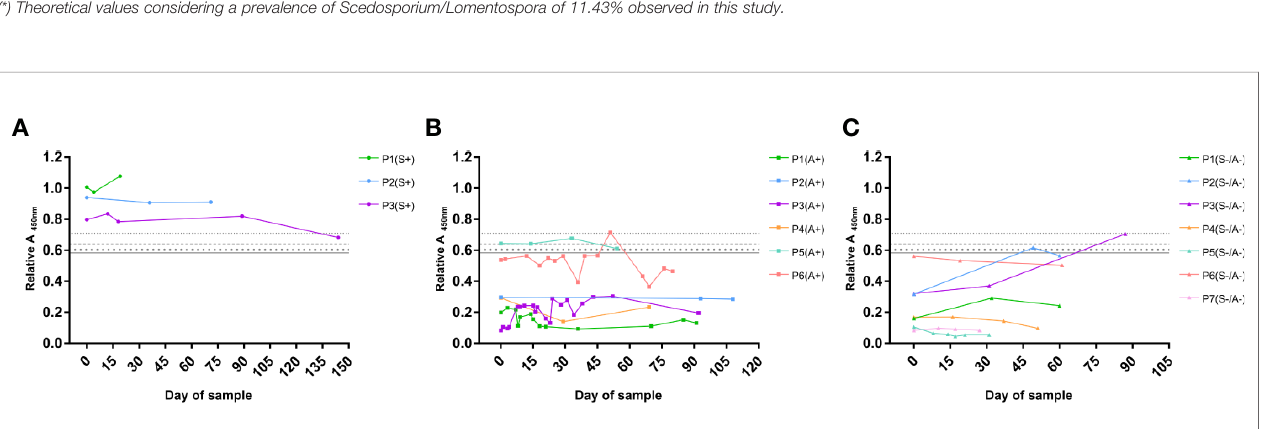
FIGURE 8 | Monitoring of speci fi c IgG serological response of CF patients against S. boydii . Example of representative patients of the Scedo+ group (A) , Asp+ group (B) , and Scedo-/Asp- group (C) . Relative Abs values of the ELISA test using a total WCP of S. boydii are depicted on a time